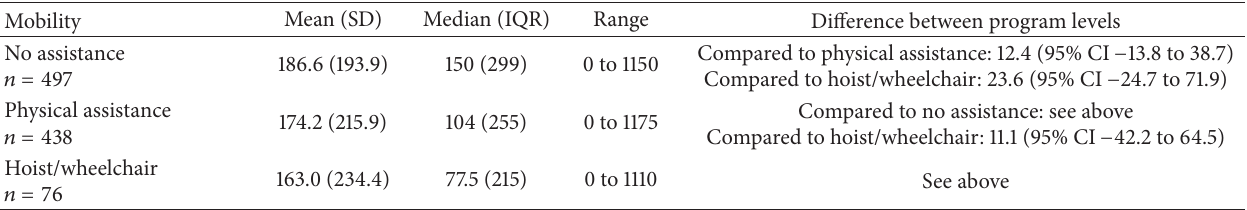
Table 4: Comparison of the amount of exercise repetitions completed in each Weekend Warrior class for mobility level. Mobility Mean (SD) Median (IQR)